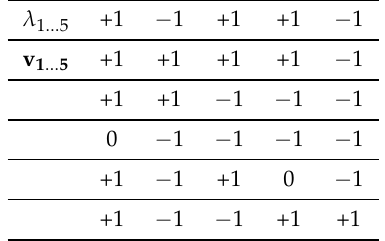
Table 10. Fault signature for gas cooler fouling.